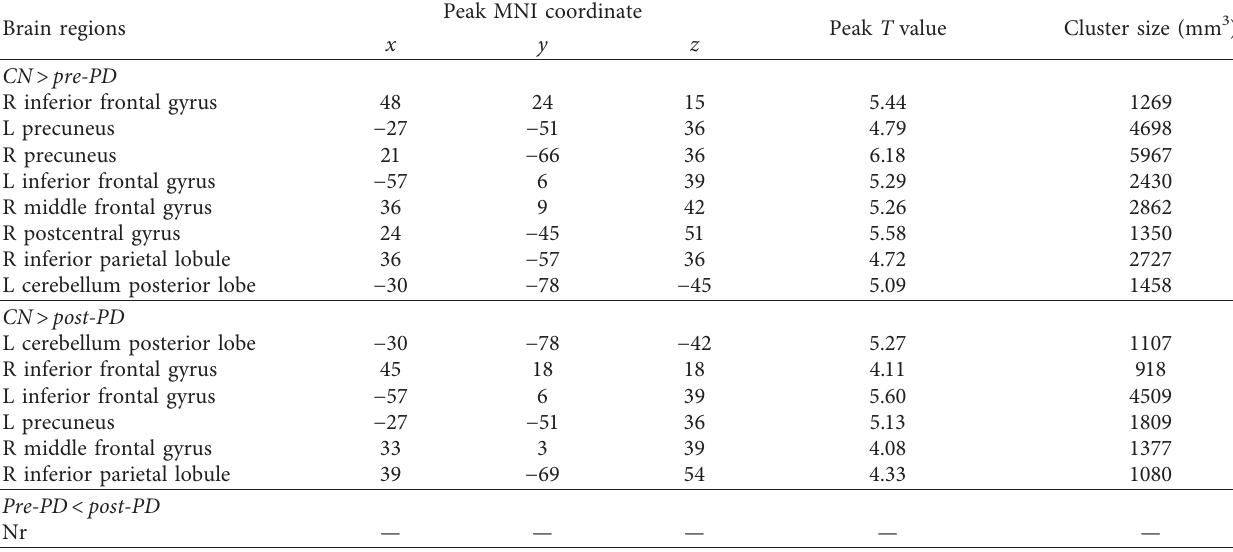
Table 2: Comparisons of functional connectivity of the brain networks during CN, pre-PD, and post-PD. Brain